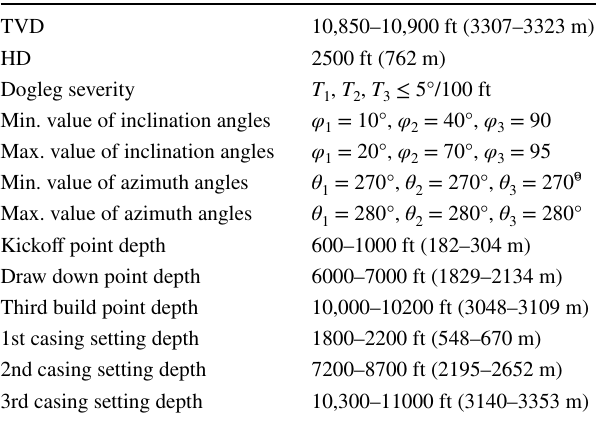
Table 2 Constraints applied to the example well path (Case 2, after Shokir et al.